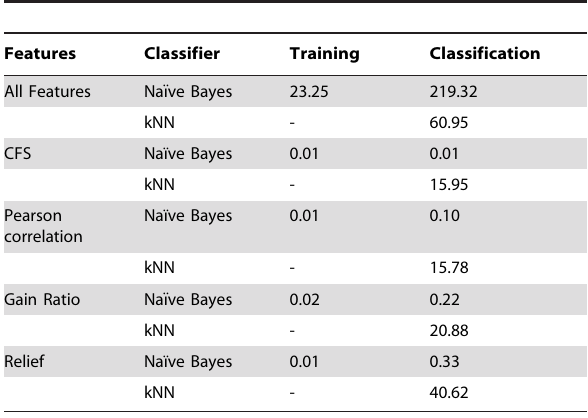
Table 11. Time (s) spent training the models and performing